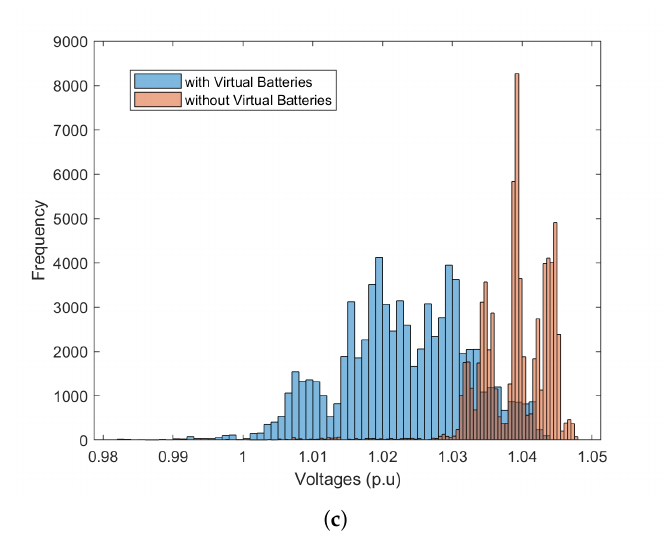
Figure 18. Distribution of voltage magnitudes for all nodes during peak hour (11:00 to 12:00). ( a ) Feeder 1. ( b ) Feeder 2. ( c ) Feeder 3.